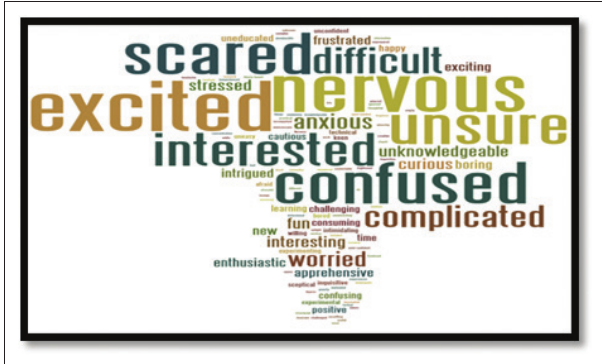
FIGURE 1: Sample of an initial word